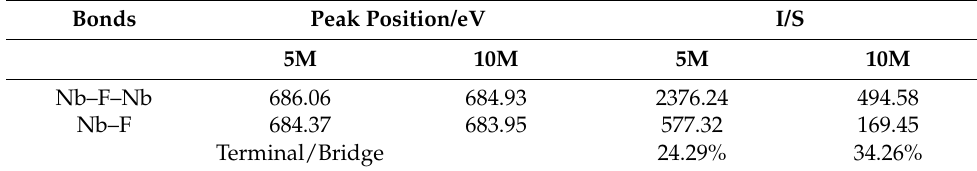
Figure 11. High-resolution XPS spectra of F 1s of the FeNb 2 O 6 before and after different concentrations of HF leaching: ( a ) 5 mol/L HF; ( b ) 10 mol/L HF. Table 4. F 1s orbital binding energy after 5 M and 10 M HF acid leaching FeNb 2 O 6.